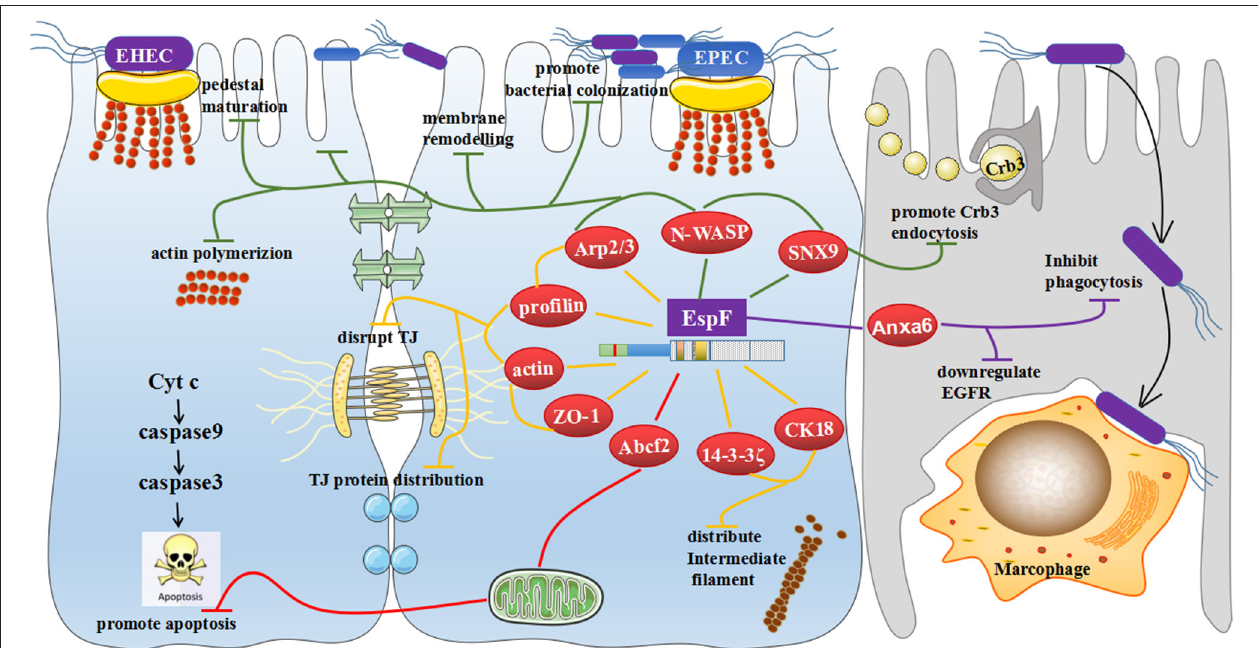
FIGURE 5 | General view of the biological effects mediated by EspF binding to host proteins. EspF interacts with SNX9 to promote endocytosis of the Crb3 protein; combines with SNX9, N-WASP, and Arp2/3 proteins to maturate pedestals; regulates actin polymerization to induce remodeling of cell membranes and potentially promote colonization of pathogenic bacteria; cooperates with Arp2/3, profilin, actin, and ZO-1 to redistribute actin and potentially disrupt the TJs; interacts with 14-3-3 ζ and CK18 to redistribute intermediate filaments, which may also promote the destruction of TJs; interacts with Abcf2, which may mediate apoptosis through the mitochondrial pathway; and interacts with Anxa6, which may downregulate EGFR levels and inhibit phagocytosis.